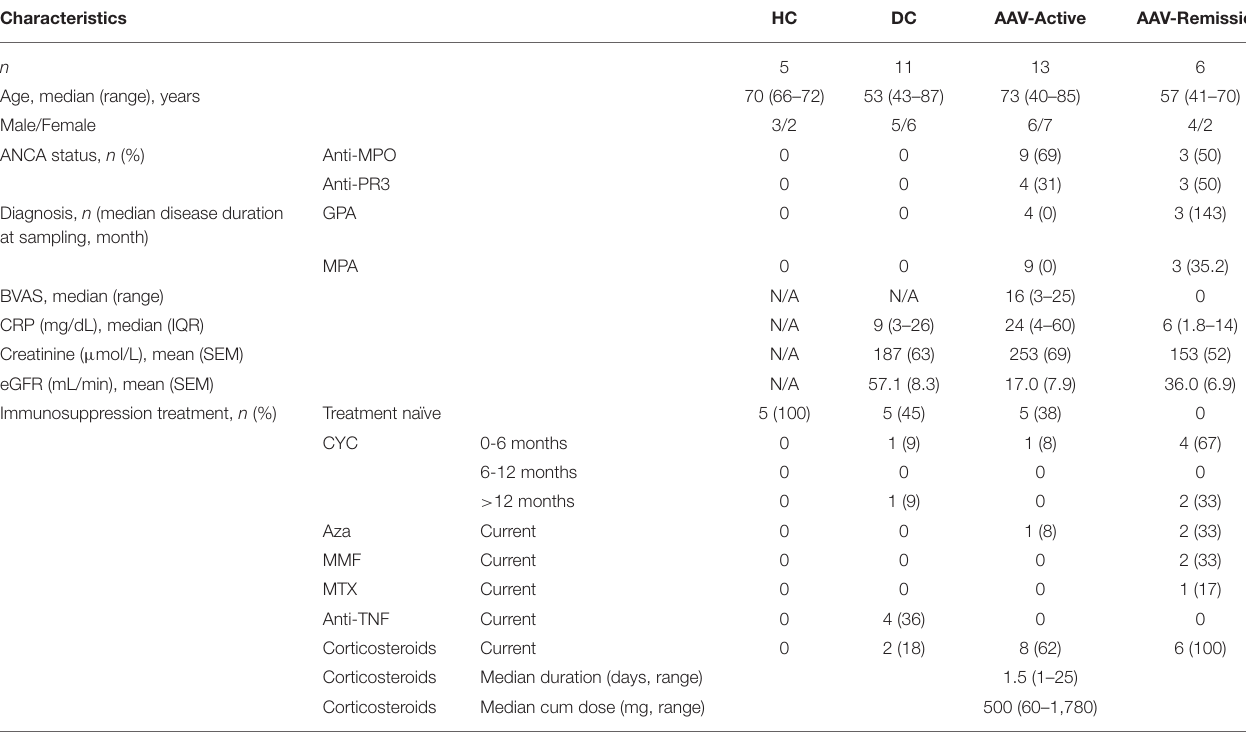
TABLE 2 | Baseline characteristics of the study subjects, by disease classification.